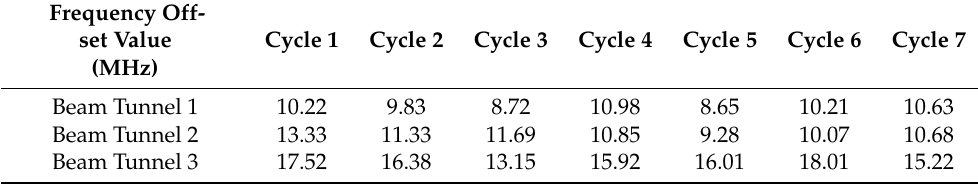
Table 3. Experimental data.